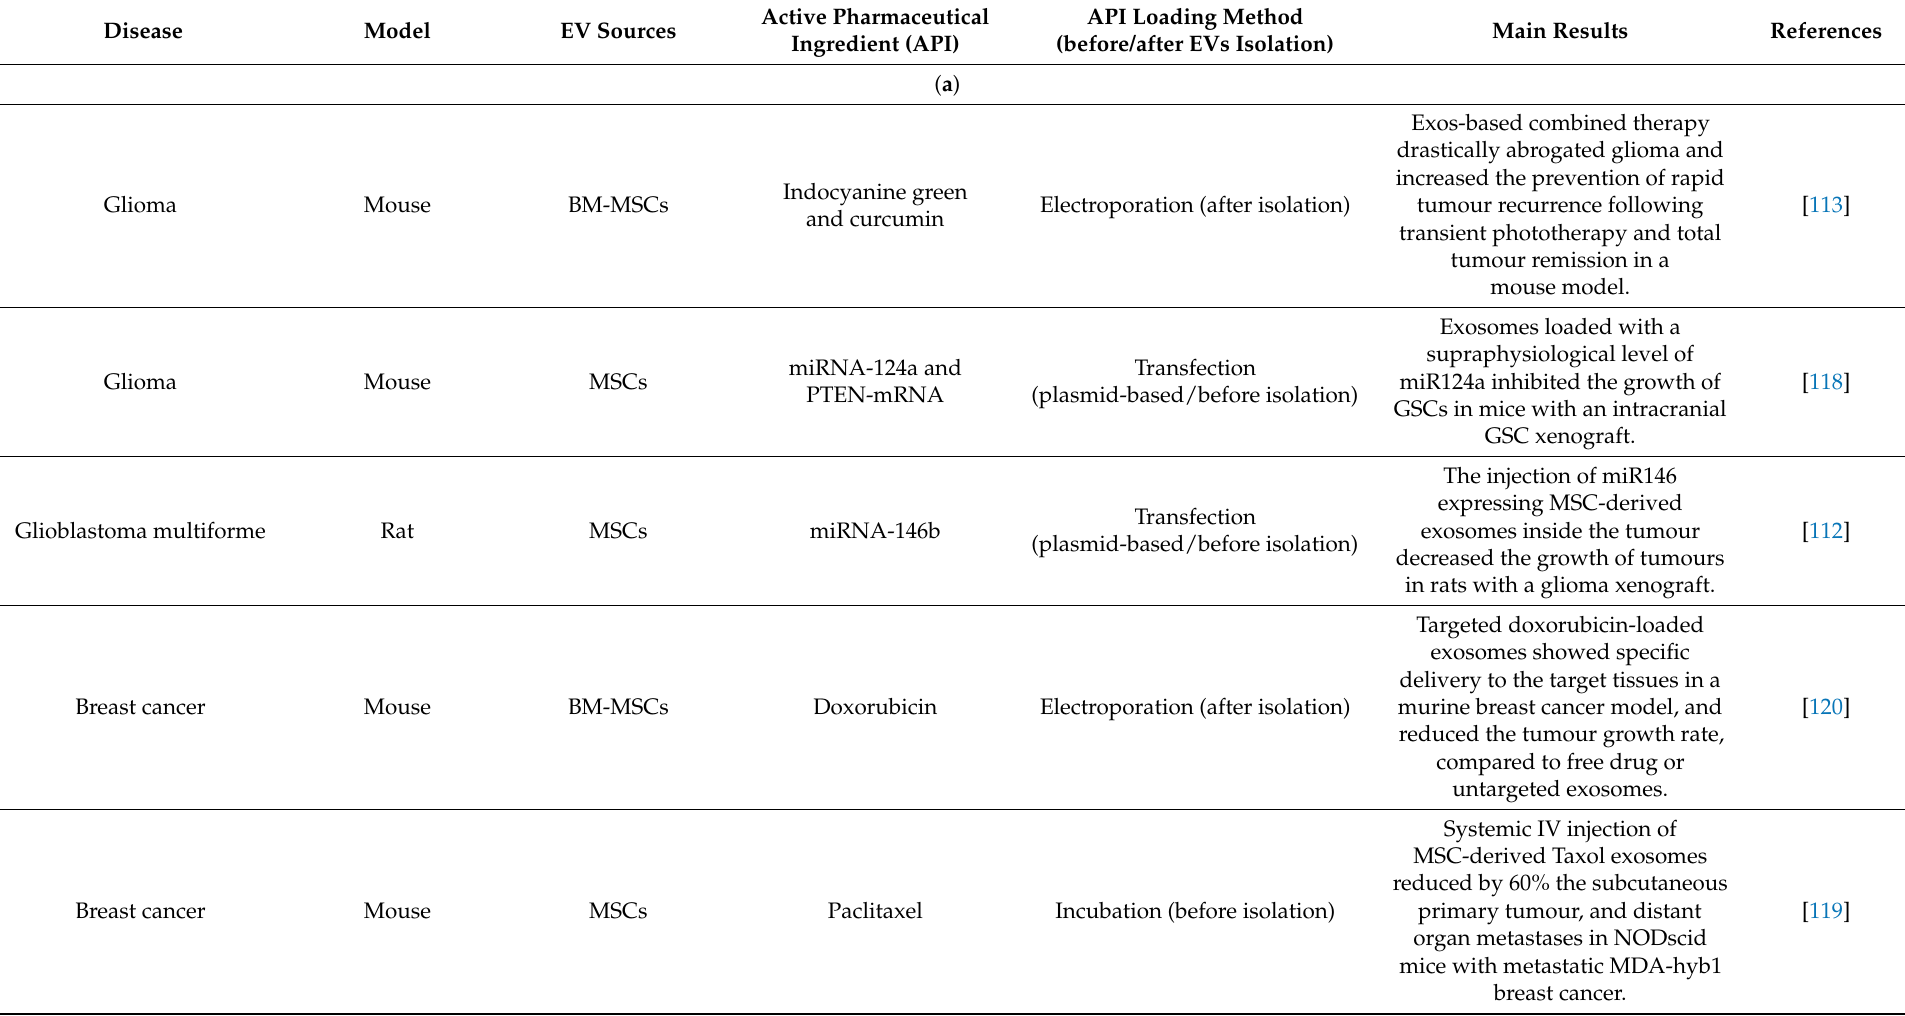
Table 4. ( a ) Pre-clinical in vivo studies using EV as DDS in cancerous pathologies. ( b ) Pre-clinical in vivo studies using EV as DDS in non-cancerous